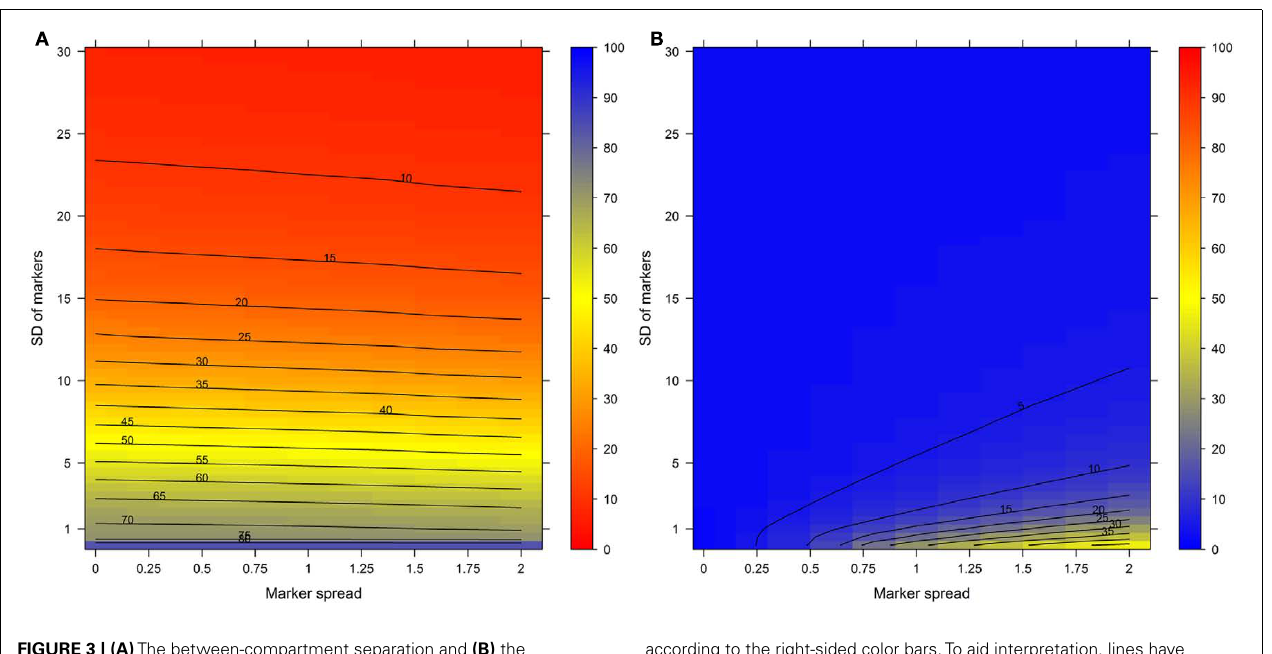
FIGURE 3 | (A) The between-compartment separation and (B) the within-compartment cohesion in dependence of the SD and marker spread. Both indices were estimated as mean–average of normalized, percentage-scaled Manhattan distances either (A) between or (B) within-compartmental clusters and are depicted as level plots color-coded